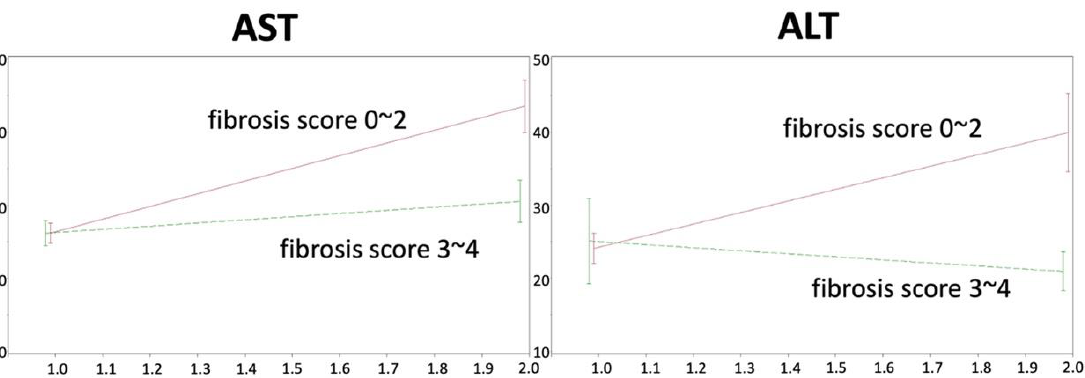
Figure 3. GEE analysis of liver enzymes before and after esophagectomy. Abbreviations: AST, aspartate transaminase; ALT, alanine acetyltransferase.